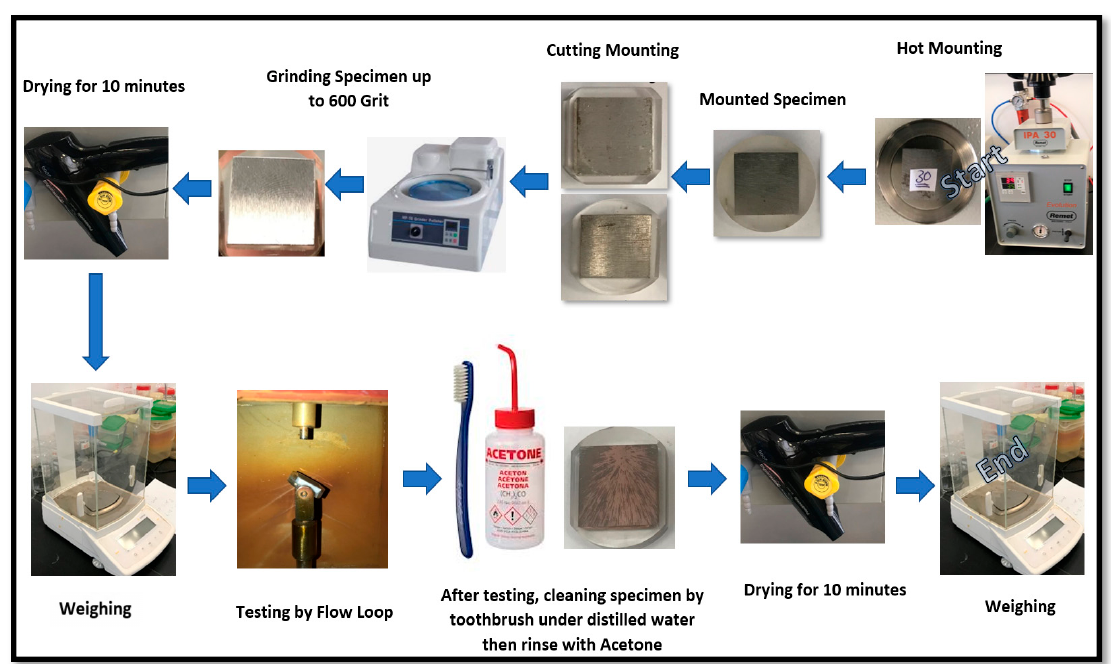
Figure 2. Testing specimens’ preparation steps before and after CO 2 erosion–corrosion.